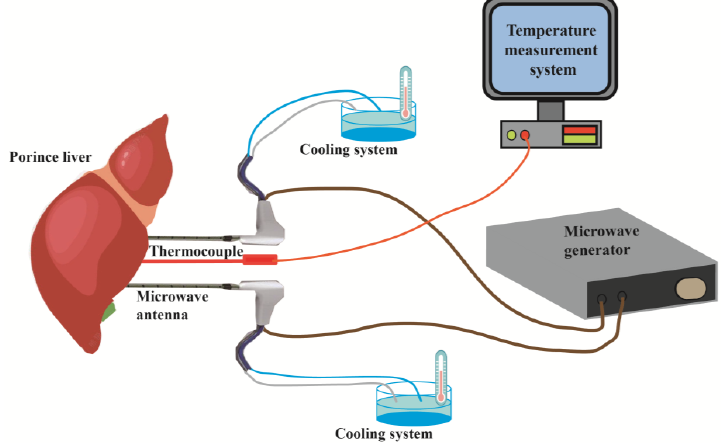
Figure 1. Experimental platform for dual-antenna MWA.